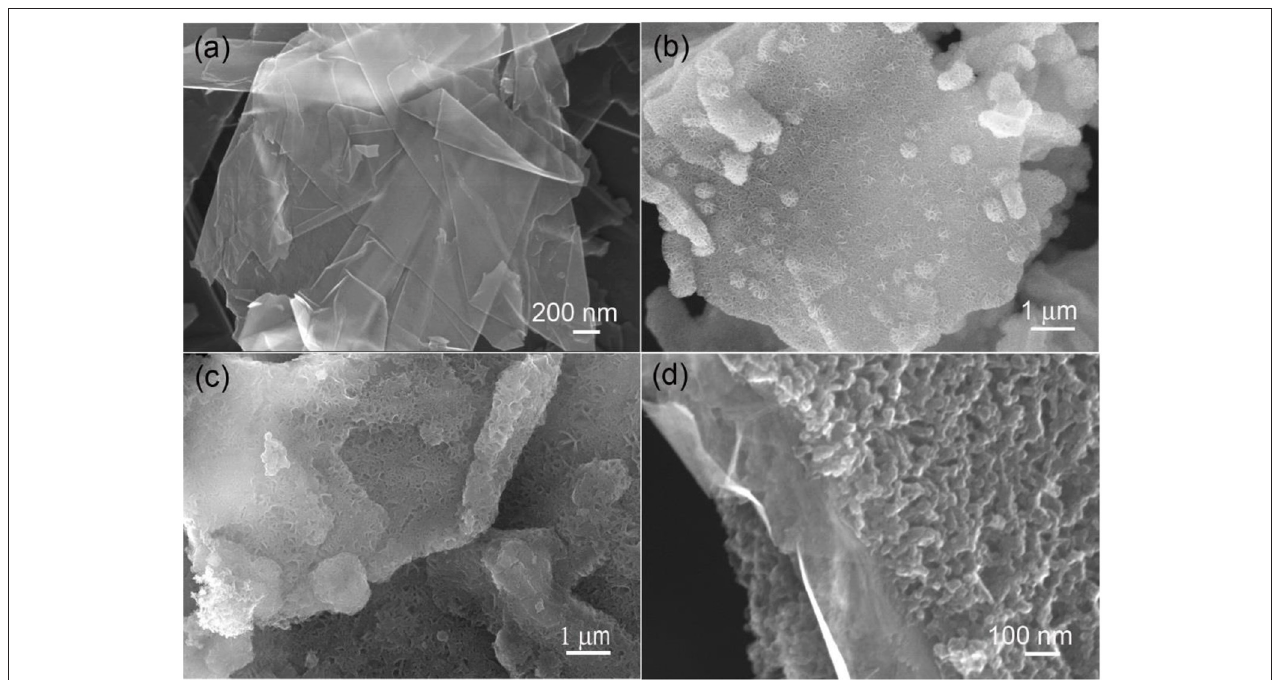
FIGURE 1 | SEM images of the starting graphene nanoplatelets (a) , the graphene nanoplatelets coated by birnessite MnO 2 (b) , PPy (c) , and N-doped amorphous carbon nanoarrays (d)